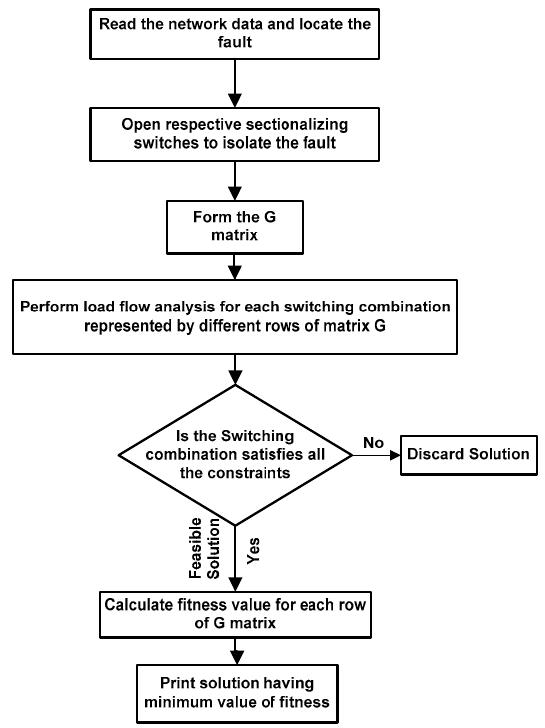
Figure 4. Service restoration through conventional deterministic method.